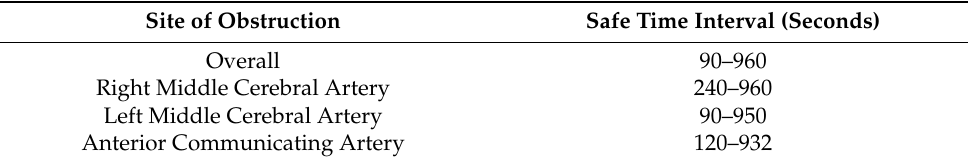
Table 2. Output values. The safe clipping time interval is based on the aneurysm location.